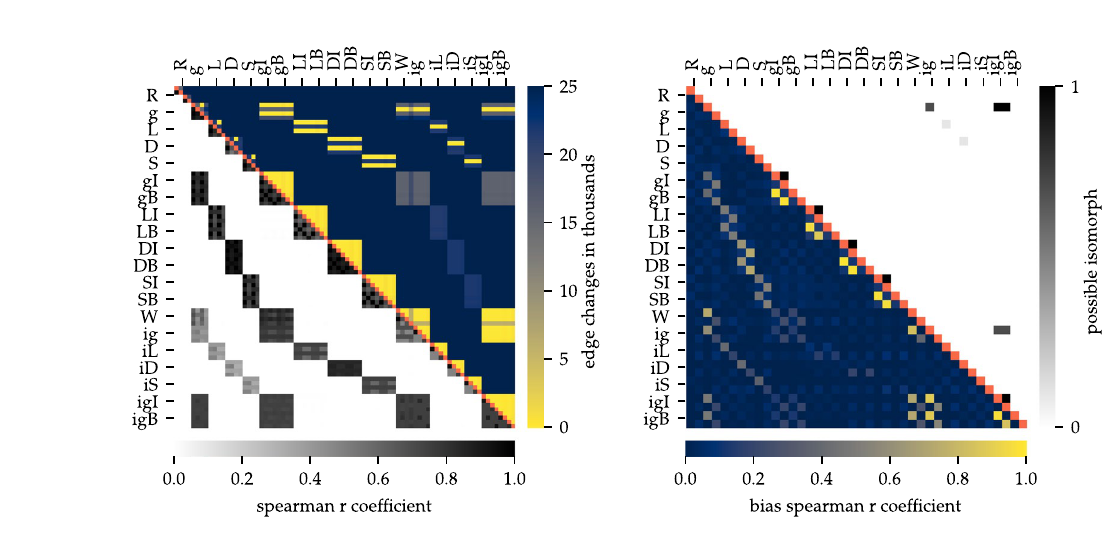
Figure 7. Weight relation of a LeNet 300-100 architecture between initialisation and post trained state.